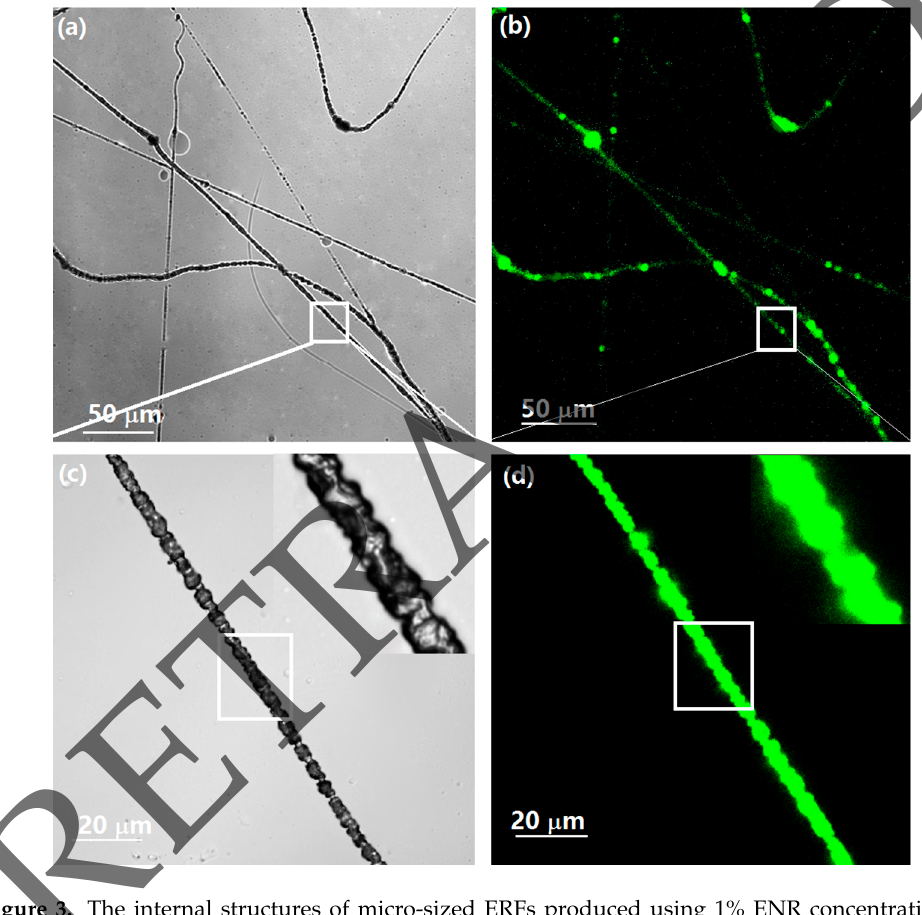
Figure 3. The internal structures of micro-sized ERFs produced using 1% ENR concentration by CLSM: ( a ) the brightfield image of ERFs; ( b ) the fluorescent image of ERFs at low magnification; ( c ) the brightfield image of the white square area; ( d ) the fluorescent image of the white square area (green color corresponds to ENR stained with fluorescent dye).